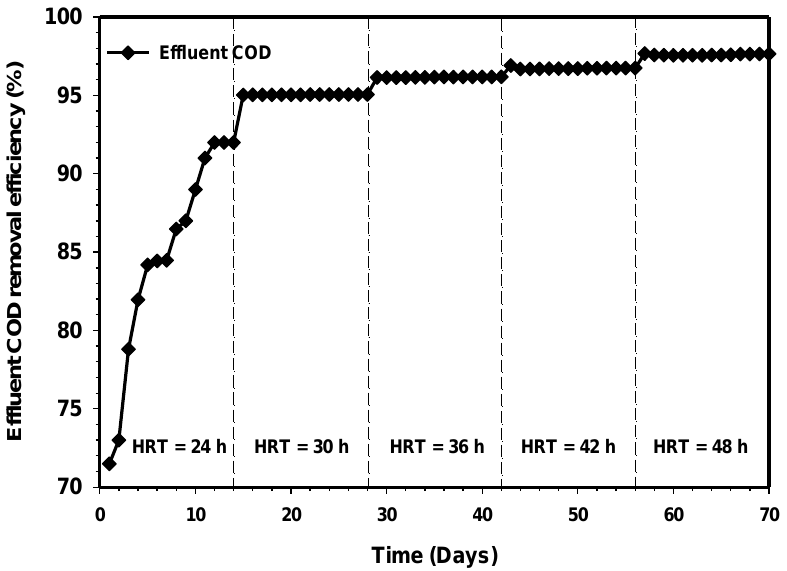
Figure 5. Variation of COD removals relative to increasing contact time .